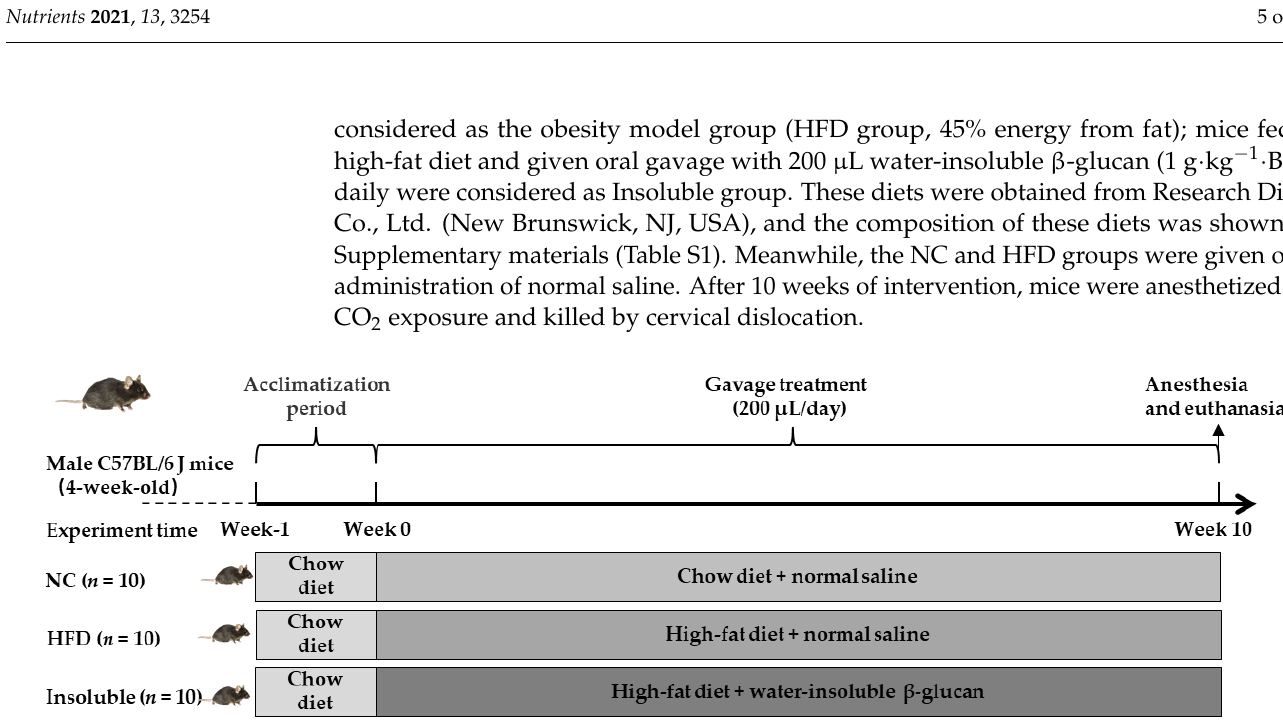
Figure 1. Overview of experimental design.